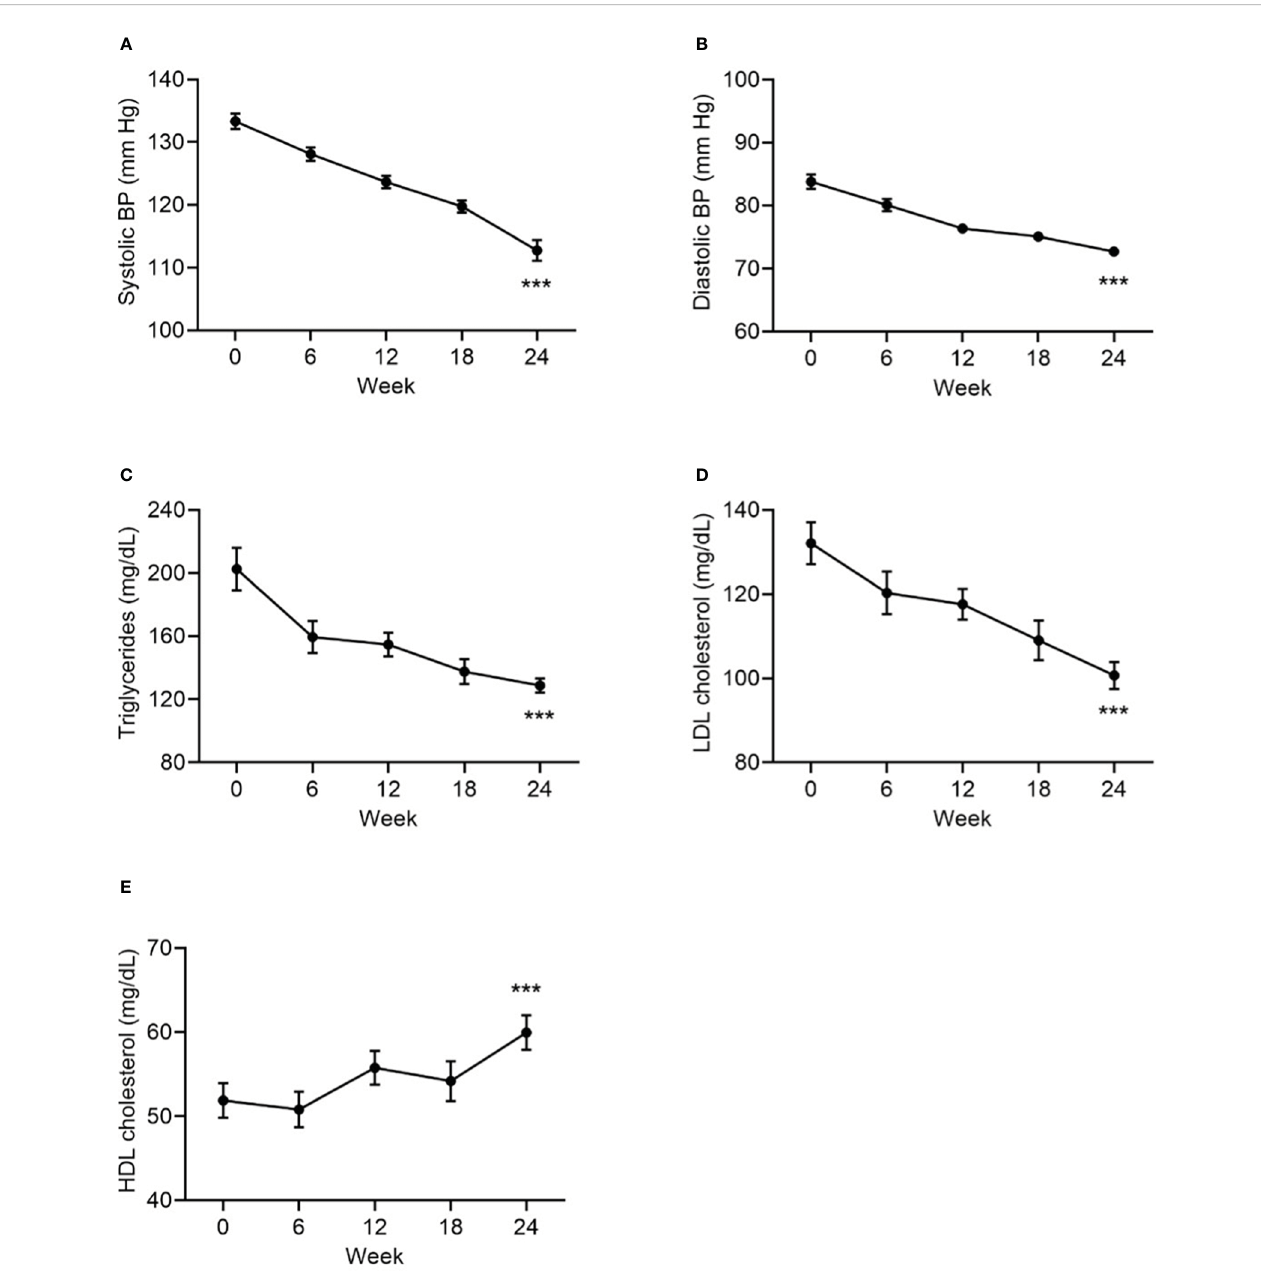
FIGURE 4 Change from baseline to Week 24 in systolic BP (A) , in diastolic BP (B) , in triglycerides (C) , in LDL cholesterol (D) , and HDL cholesterol (E) , as cardiometabolic markers. Data are mean ± SE by visit for all participants (N=84). BP, blood pressure. ***p<0.001 for baseline vs